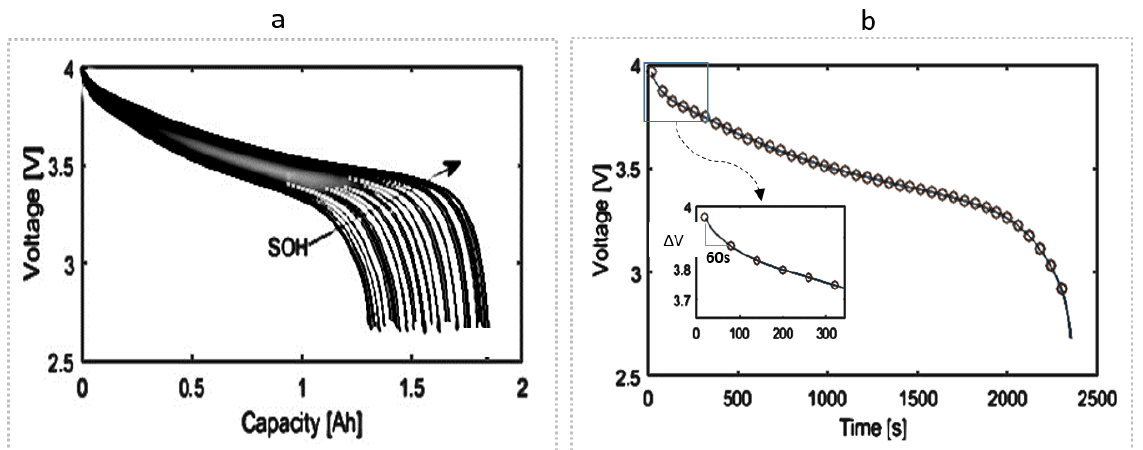
Figure 4. ( a ) Voltage vs. capacity plot: the output of a constant current discharge profile. Each curve represents a single cycle. The arrow is the reverse direction of aging across cycles. ( b ) The data points are taken at a 60 s interval to obtain the variation of voltage used as the feature